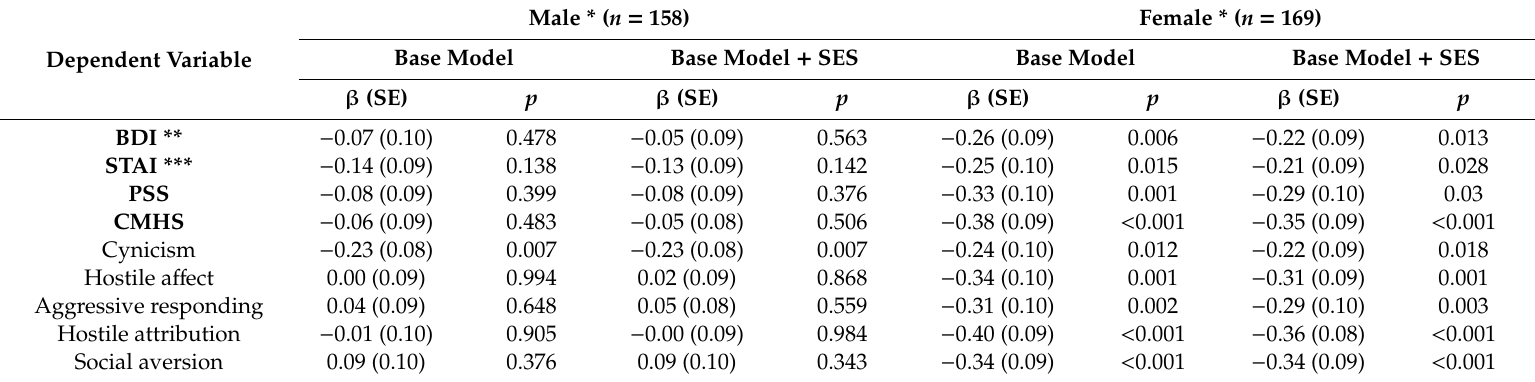
Table 3. Adjusted associations between mental health and serum 25(OH)D concentrations stratified by gender.